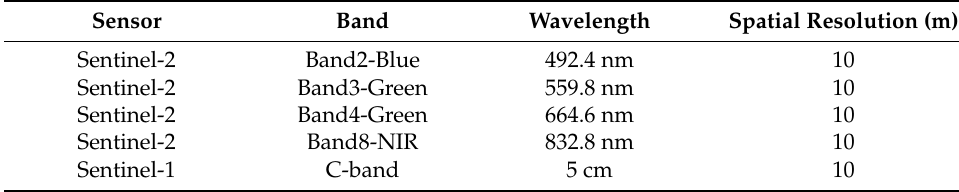
Figure 4. Selection of an appropriate region to derive the threshold for processing Sentinel-1. ( a ) Orignal Sentinel-1 image on 29/10/2020; ( b ) Histogram of backscatter distribution in the region contained by blue box in ( a ); ( c ) Region contained by red box in ( a ); ( d ) Water body extraction based on Sentinel-1 image and Otsu’s method.